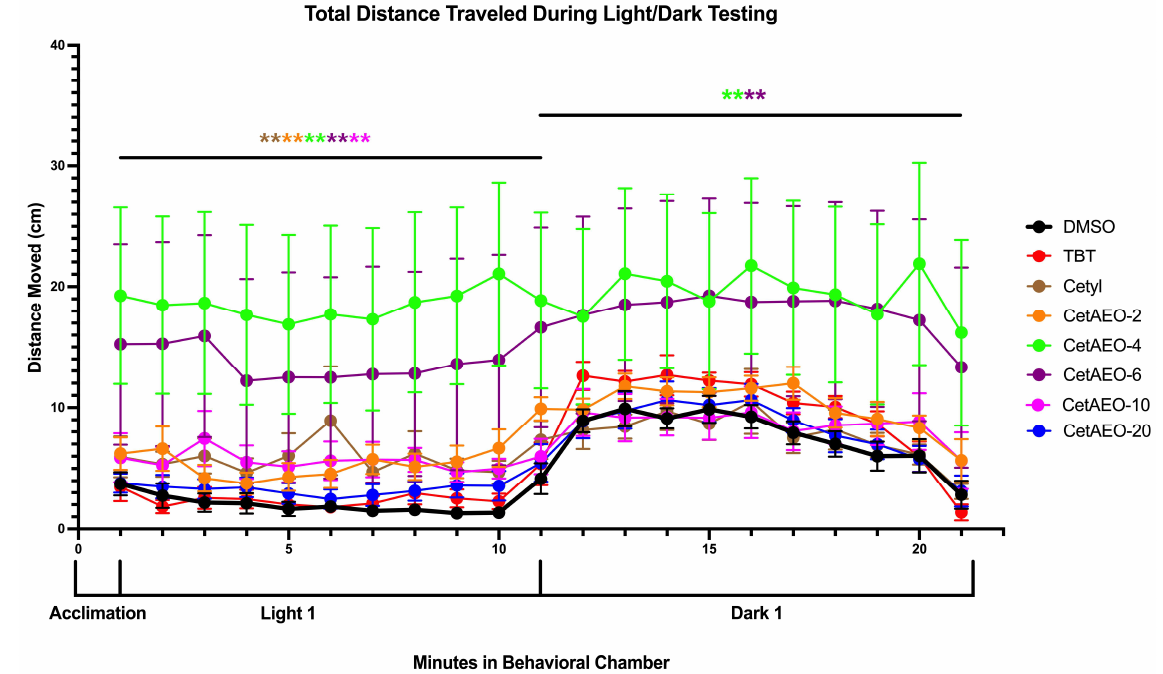
Figure 4. Total Distance Traveled During Light/Dark Neurodevelopmental Testing. Zebrafish were developmentally exposed to control chemicals, cetyl alcohol or cetyl alcohol polyethoxylates. Immediately following exposure, at six days post fertilization, activity was tracked using Noldus Ethovision software as described in Methods. Three replicate fish were transferred into wells of a 24-well clear-bottom plate, and the total activity was tracked using an acclimation period followed by one ten − minute light and then one ten − minute dark period. Experiment was completed at least three times (biological replicates). Total activity across the entire ten − minute period was compared between chemical exposures and DMSO (0.1%, vehicle control) treated fish to determine significant differences. ** indicates significant increase in activity compared to vehicle control fish, p < 0.01, as per Kruskal–Wallis test with Dunn’s multiple comparisons. DMSO = dimethylsulfoxide, vehicle control; TBT = tributyltin chloride; Cetyl = cetyl alcohol; CetAEO = cetyl alcohol polyethoxylates (with varying average ethoxylate chain lengths). Concentrations provided are the highest test concentrations for each treatment (1 µ M for cetyl alcohol and ethoxylates and 0.001 µ M for TBT). Full dose responses for each chemical are provided in Figure